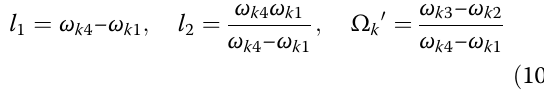
p(cid:7) 1 þ 4 a 2 = a 1